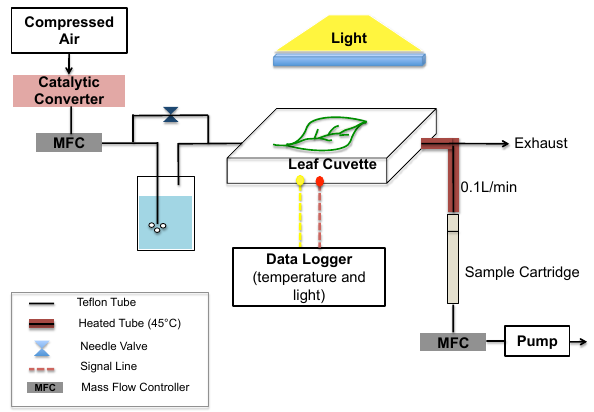
Fig. 2. A schematic of the dynamic leaf enclosure cuvette